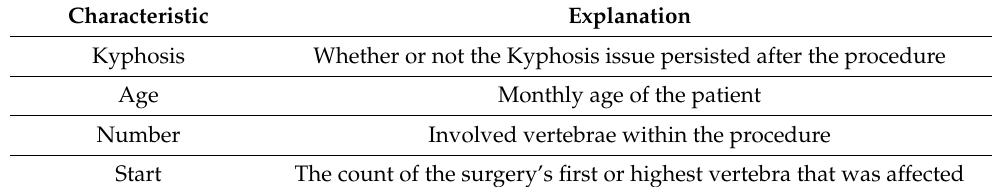
Table 1. Description of